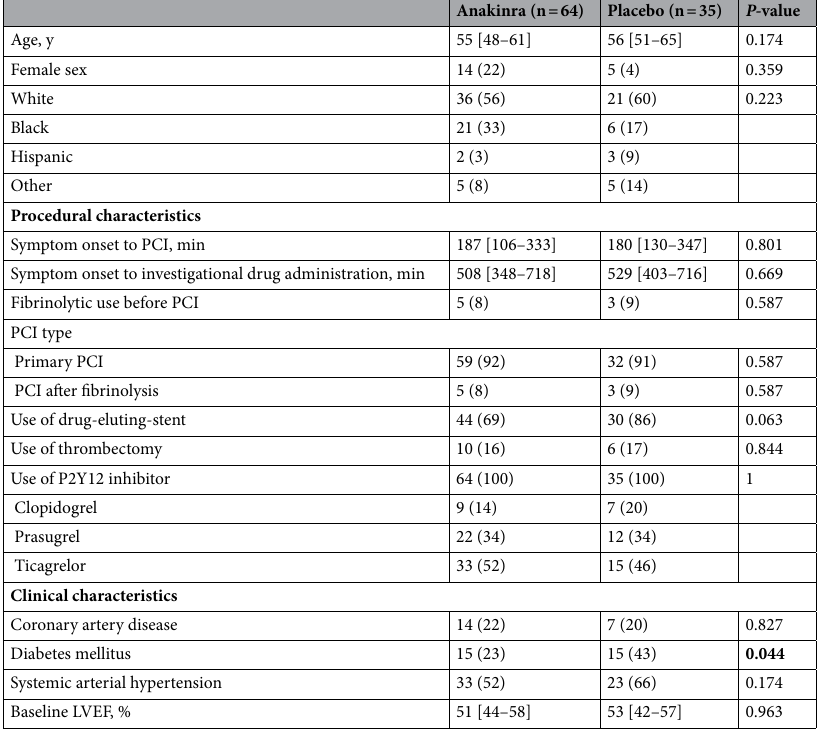
Table 1. Clinical characteristics of the patients in anakinra and placebo groups. STEMI ST elevation myocardial infarction, PCI percutaneous coronary intervention, Min minutes, LVEF left ventricle ejection fraction. Significant value are in